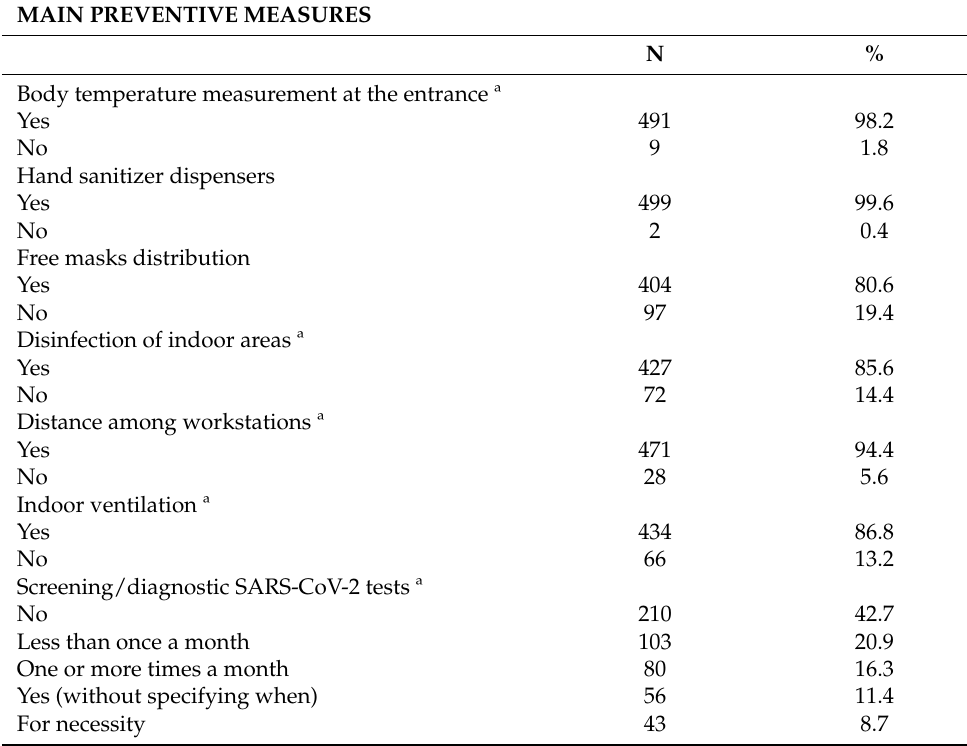
Table 2. Preventive measures provided by companies (N =